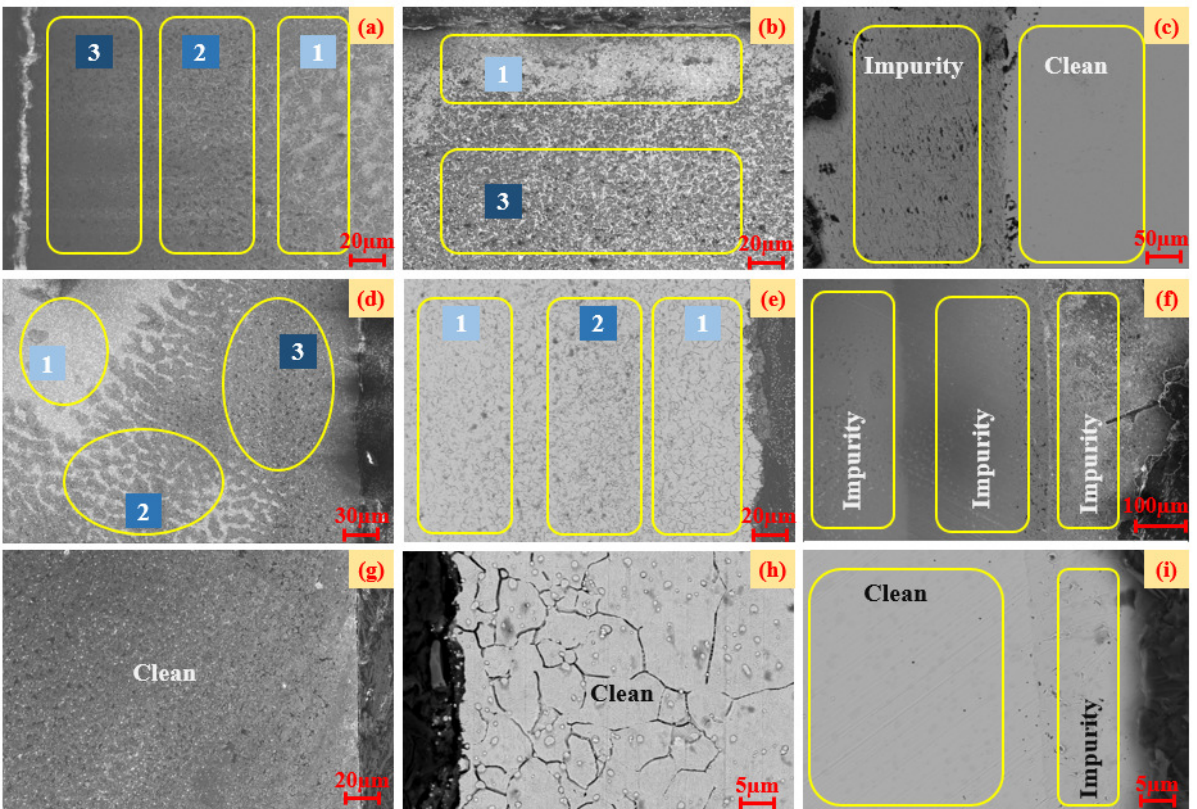
Figure 8. Comparison of the microscopic wear of high-performance bearings before and after durability experiments.